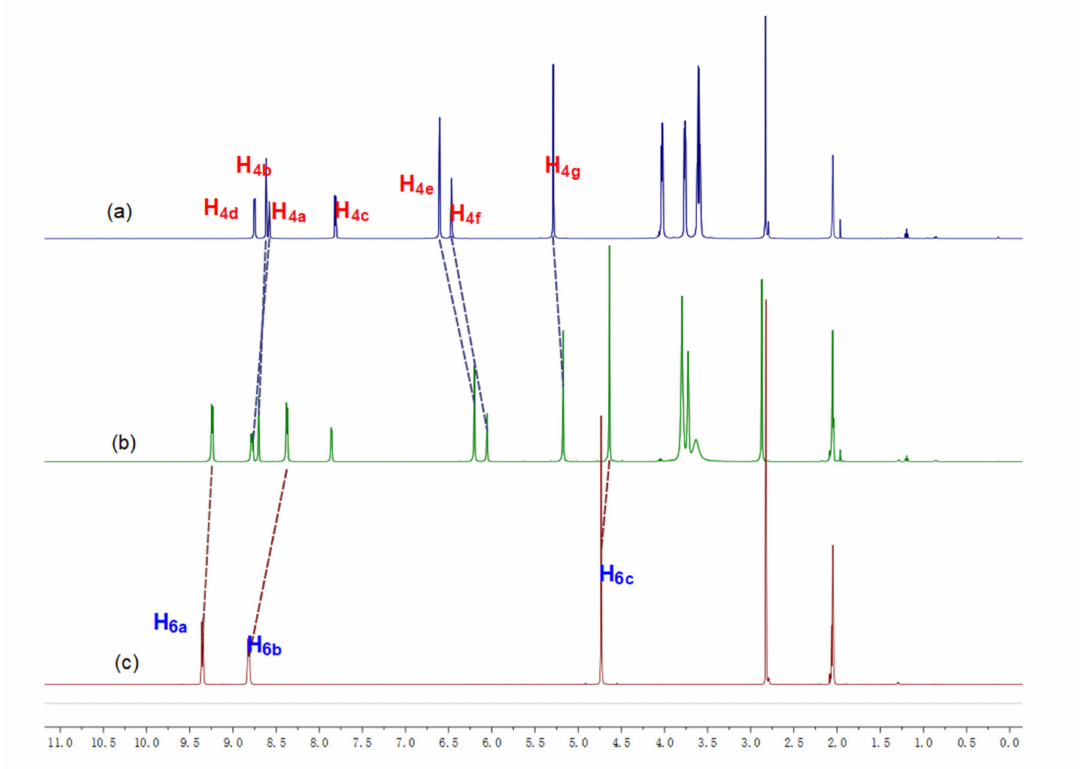
Figure 1. Proton nuclear magnetic resonance ( 1 H NMR) spectra (500 MHz, CD 3 COCD 3 , 298K) of 5.00 mM 4 ( a ), 5.00 mM 4 + 5.00 mM 6 ( b ), 5.00 mM 6 ( c ). The assignments of protons were shown in Scheme